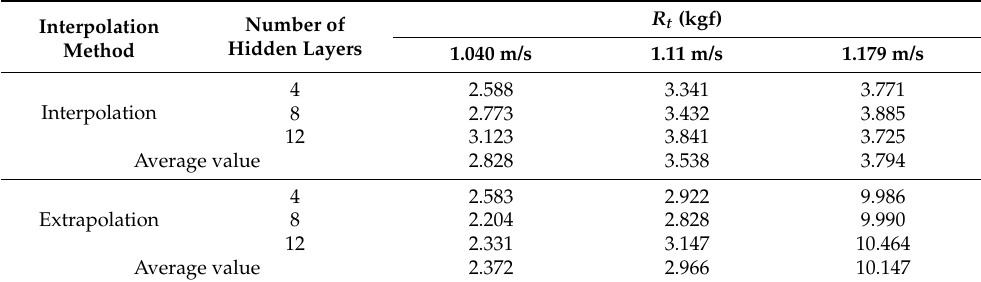
Table 8. The prediction results of model ship resistance R t using backpropagation neural network BPNN.